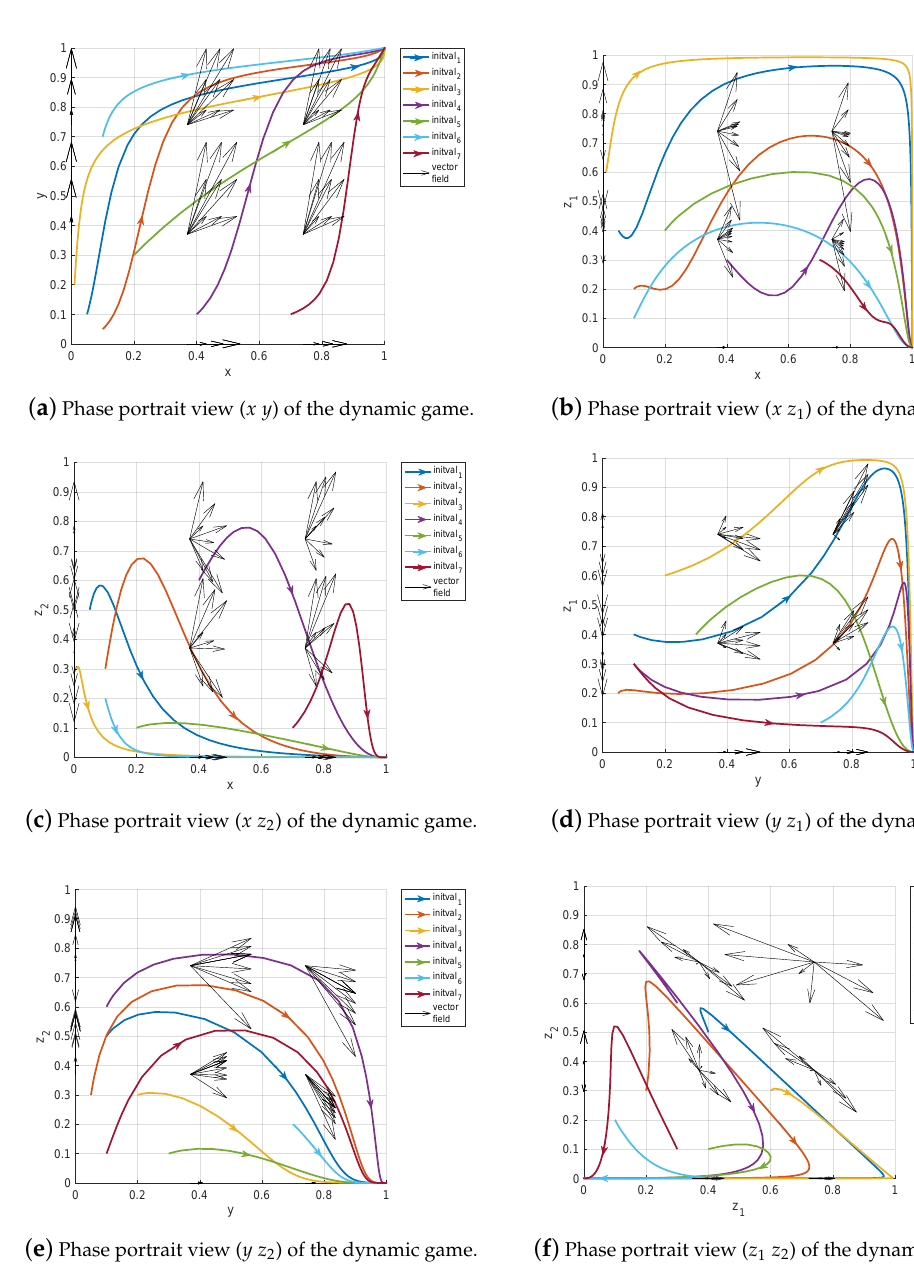
Figure 3. Four-dimensional phase portraits by state